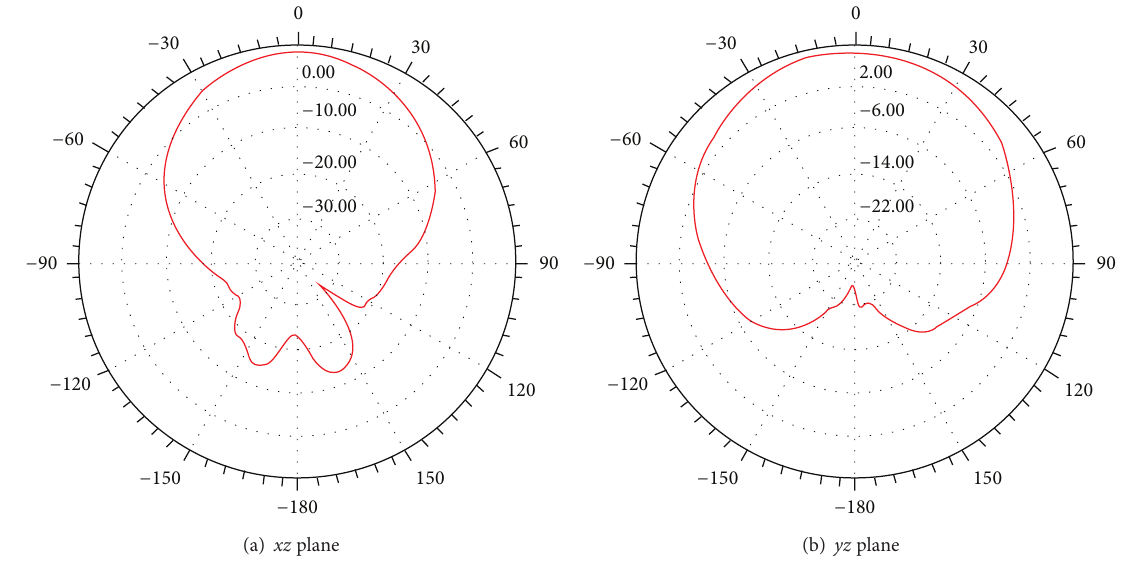
Figure 6: Simulated radiation patterns at 2.4